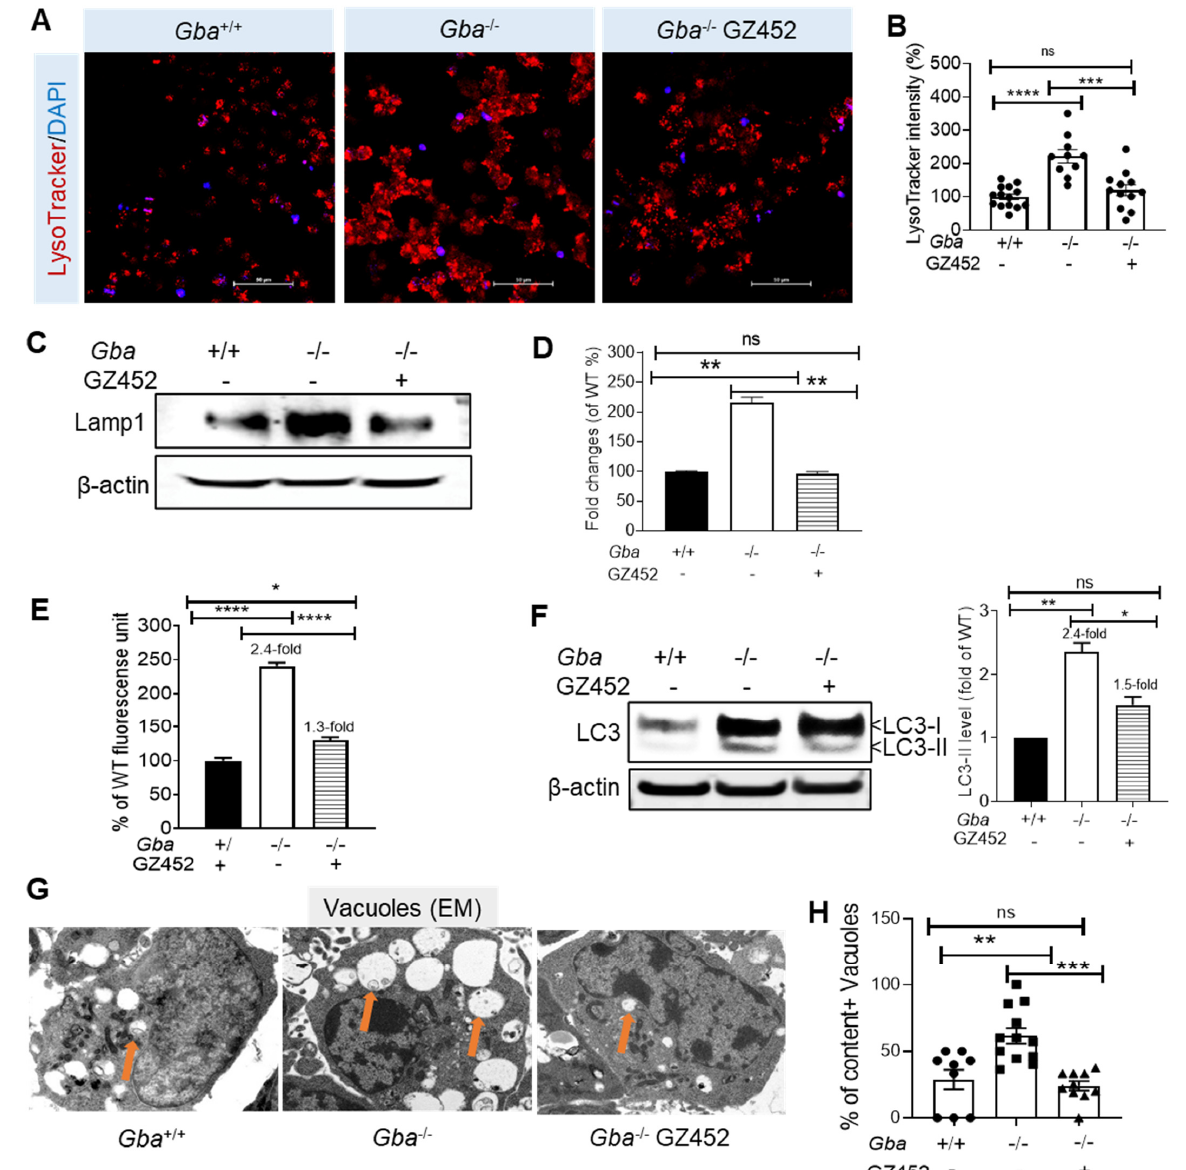
Figure 3. GZ452 treatment protected lysosome and autophagy in Gba -/- neurons. ( A ) LysoTracker-stained lysosomes (scale bar = 50 µM). ( B ) Quantitation of LysoTracker density in cells ( n ≥ 10 images). ( C ) Lamp1 and β -actin were measured by WB in neurons. ( D ) Quantitation of Lamp1 protein level after normalized with β -actin showed reduction in Lamp1 in GZ452-treated Gba -/- neurons (duplicate experiments). ( E ) Autophagy flux was analyzed in neurons by CYTO-ID ® autophagy kit. Increased fluorescence unit indicates that autophagy flux was blocked in Gba -/- neurons. GZ452 treatment improved autophagy flux from 2.4-fold to 1.3-fold above normal level (triplicate experiments, n = 8 per experiment). ( F ) LC3 and β -actin were measured by WB. After normalized with β -actin controls, quantitation data showed LC3-II level was increased in Gba -/- neurons (2.4-fold) compared with Gba +/+ and reduced to 1.5-fold in GZ452-treated Gba -/- neurons (duplicate experiments). ( G ) Gba -/- neurons contain large-size vacuoles (arrows), shown by representative EM images. Large vacuoles were not present in GZ452-treated Gba -/- neurons. ( H ) Quantitation of vacuoles with contents in neurons ( n ≥ 9 cells). One-way ANOVA analysis (* p < 0.05; ** p < 0.01; *** p < 0.001; **** p < 0.0001). ns, not statistically significant. The effect of SRT on normalizing autophagy was studied in GZ452-treated Gba -/- neurons. GZ452 treatment improved autophagy flux from 2.4-fold to 1.3-fold above nor- mal level (Figure 3E), and reduced LC3-II level from 2.4-fold to 1.5-fold (Figure 3F) in Gba -/- neurons. The size of vacuoles was reduced (Figure 3G), and the proportion